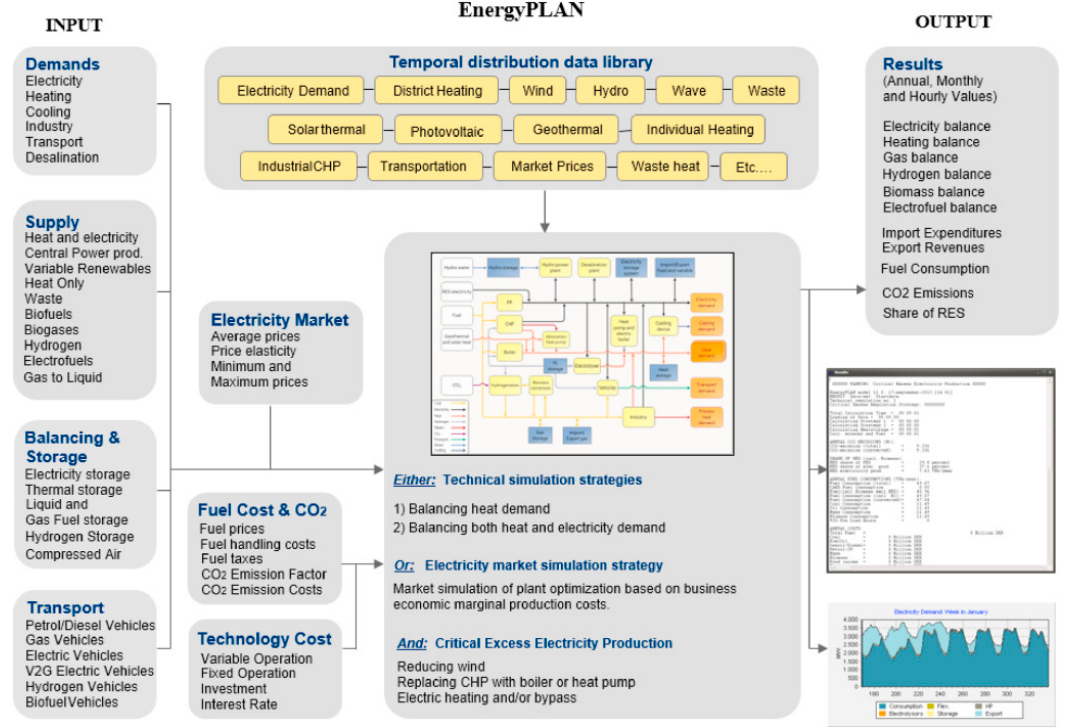
Figure 1. The schematic model of EnergyPLAN on the historical development and user inputs to define future energy demand (Reprinted with permission from Ref. [39]. Copyright 2021 Elsevier) [39].